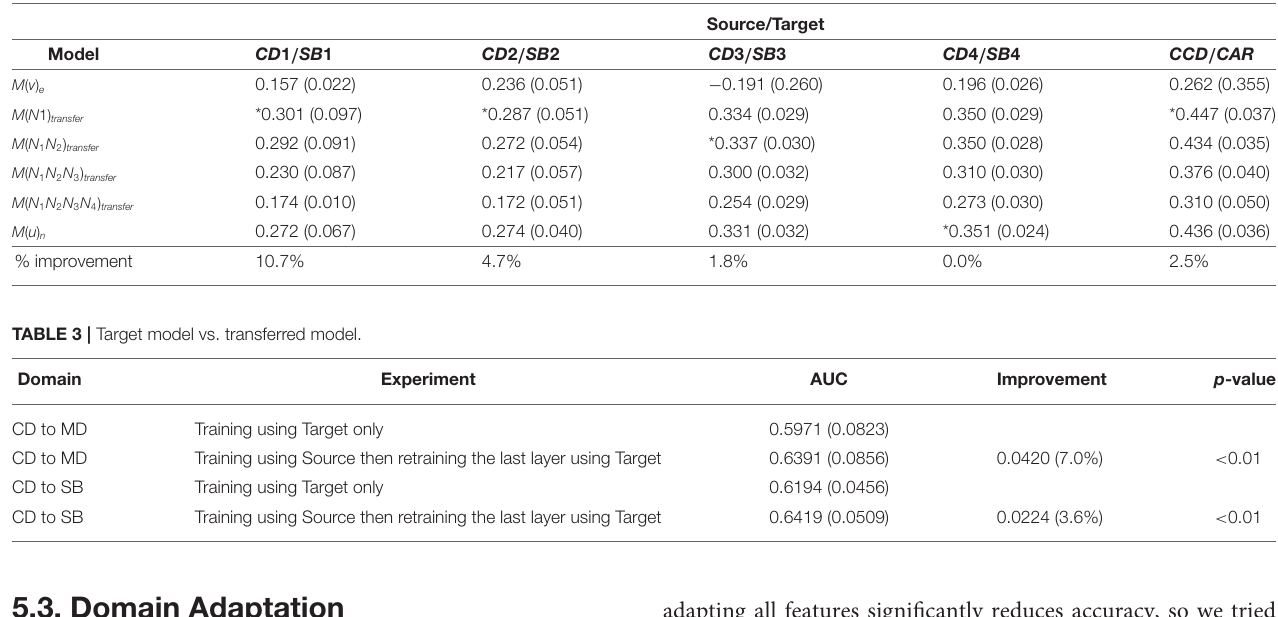
TABLE 2 | Experimental Results for six models with progressively shifted contribution, built on the source and target datasets described in Table 1 (all of the source:Credit Card/Debt Consolidation (CD), target:Small Business (SB) Loan datasets, plus the source:Credit Card, target:Car Loan datasets); results shown as means (s.d.) ; models with the highest performance in each column are denoted by the symbol *.